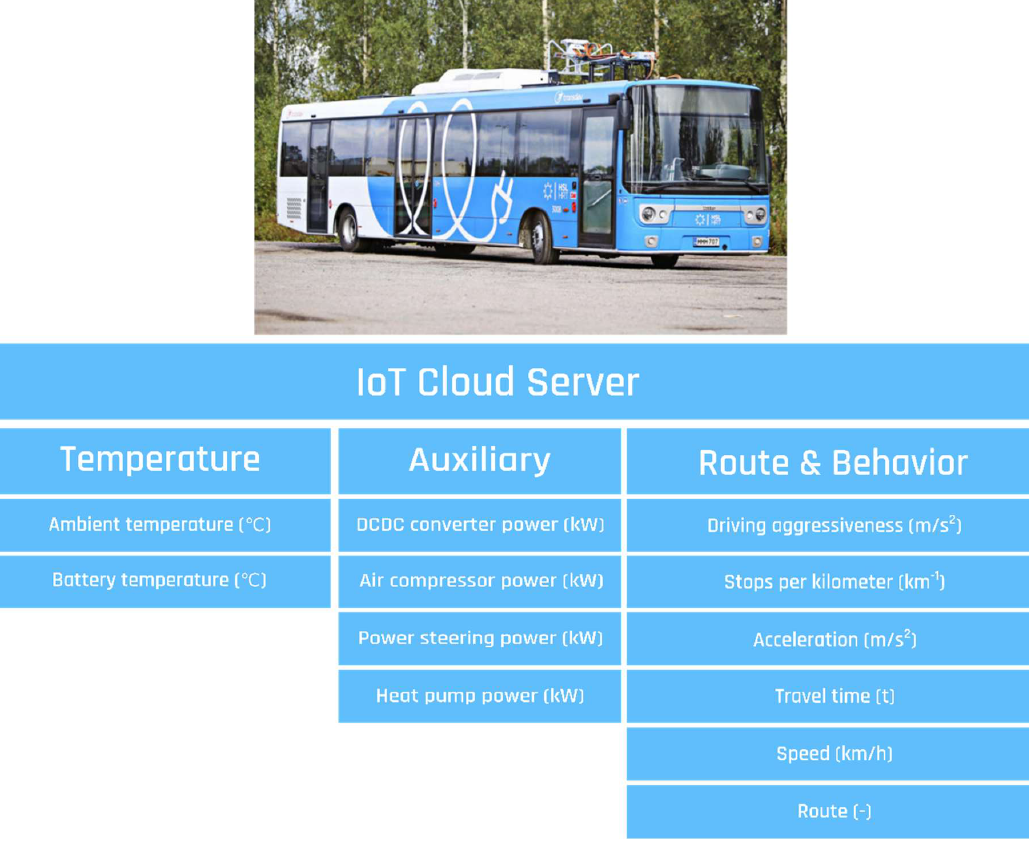
Figure 2. Operation factor data that were gathered from the battery electric buses (BEBs), using an Internet of Things (IoT) cloud server platform. Energies 2018 , 11 , x